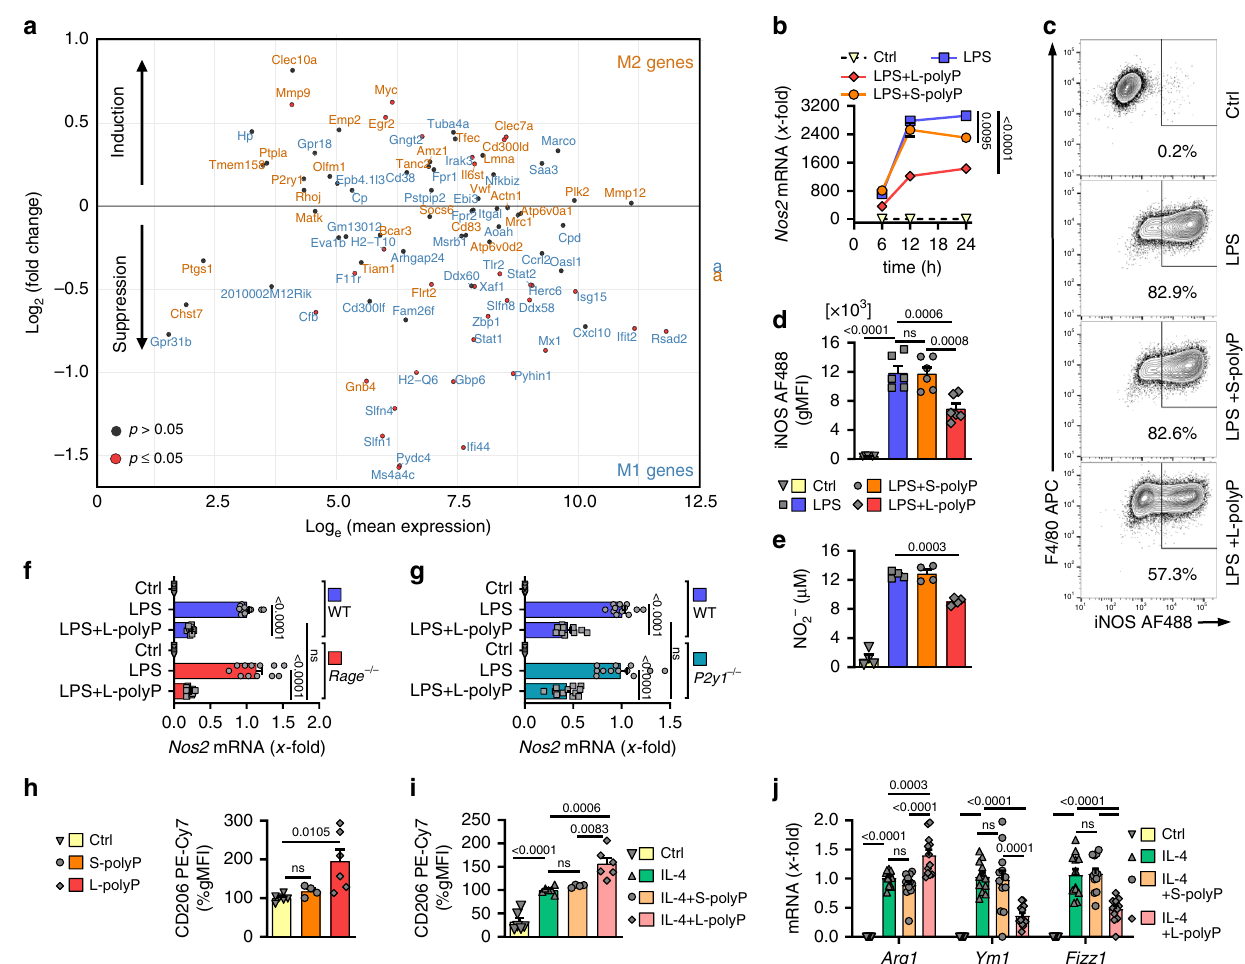
Fig. 3 Polyphosphates attenuate LPS-induced M1 macrophage polarization in favor of increased M2 characteristics. a RNA-seq analysis of M1 (blue) and M2 (orange) markers in macrophages (BMDM, C57BL6/J) stimulated for 12 h with LPS ± long-chain polyphosphates (L-polyP, n = 5/group). Differentially expressed genes (adjusted p value ≤ 0.05) of LPS + L-polyP vs. LPS alone are indicated as red dots. b Time course of iNOS ( Nos2 ) mRNA as archetype M1 marker induced by LPS ± S-/L-polyP and untreated controls (Ctrl), RT-qPCR ( n = 4 samples/group for each time point). c Intracellular iNOS induced by LPS ± S-/L-polyP after 24 h in macrophages by representative fl ow cytometry pre-gated on CD11b + cells (CD11b-Paci fi c Blue). d Intracellular iNOS as geometric mean fl uorescence intensities (gMFI) in CD11b + F4/80 + macrophages from groups of mice ( n = 6) as in frame ( c ). e NO 2 − concentrations in macrophage supernatants as surrogate for NO production after LPS ± S-/L-polyP, 24 h ( n = 4 samples/group). f Rage − / − and WT macrophages were compared for iNOS ( Nos2 ) mRNA after LPS ± L-polyP. The expression values of LPS-stimulated WT macrophages were set as onefold for normalization, 12 h, RT-qPCR ( n = 12/group). g P2y1 − / − macrophages and WT macrophages analyzed for iNOS ( Nos2 ) expression after LPS ± L-polyP, 12 h, RT-qPCR ( n = 12/group). h , i Expression of the M2 marker, CD206, as determined by intracellular fl ow cytometry and expressed as normalized gMFI. Macrophages were incubated with S-polyP or L-polyP for 24 h ( h ) or preincubated 24 h with IL-4 before 24 h stimulation with S-/L-polyP ( i ), h , i n = 6/ group exept where S-polyP ( n = 4). j Expression of M2 markers Arg1 , Ym1 , and Fizz1 by BMDM stimulated 48 h with IL-4± S-/L-polyP, RT-qPCR ( n = 12/ group). Data are expressed as mean ± s.e.m. and representative ( b , e ) or combined ( d , f – j ) as examined over three independent experiments, b two-way ANOVA (F(1,6) LPS vs. LPS + L-polyP = 754.3 and F(1,6) LPS vs. LPS + S-polyP = 14.06), d – j one-way ANOVA, ns not signi fi cant ( p >